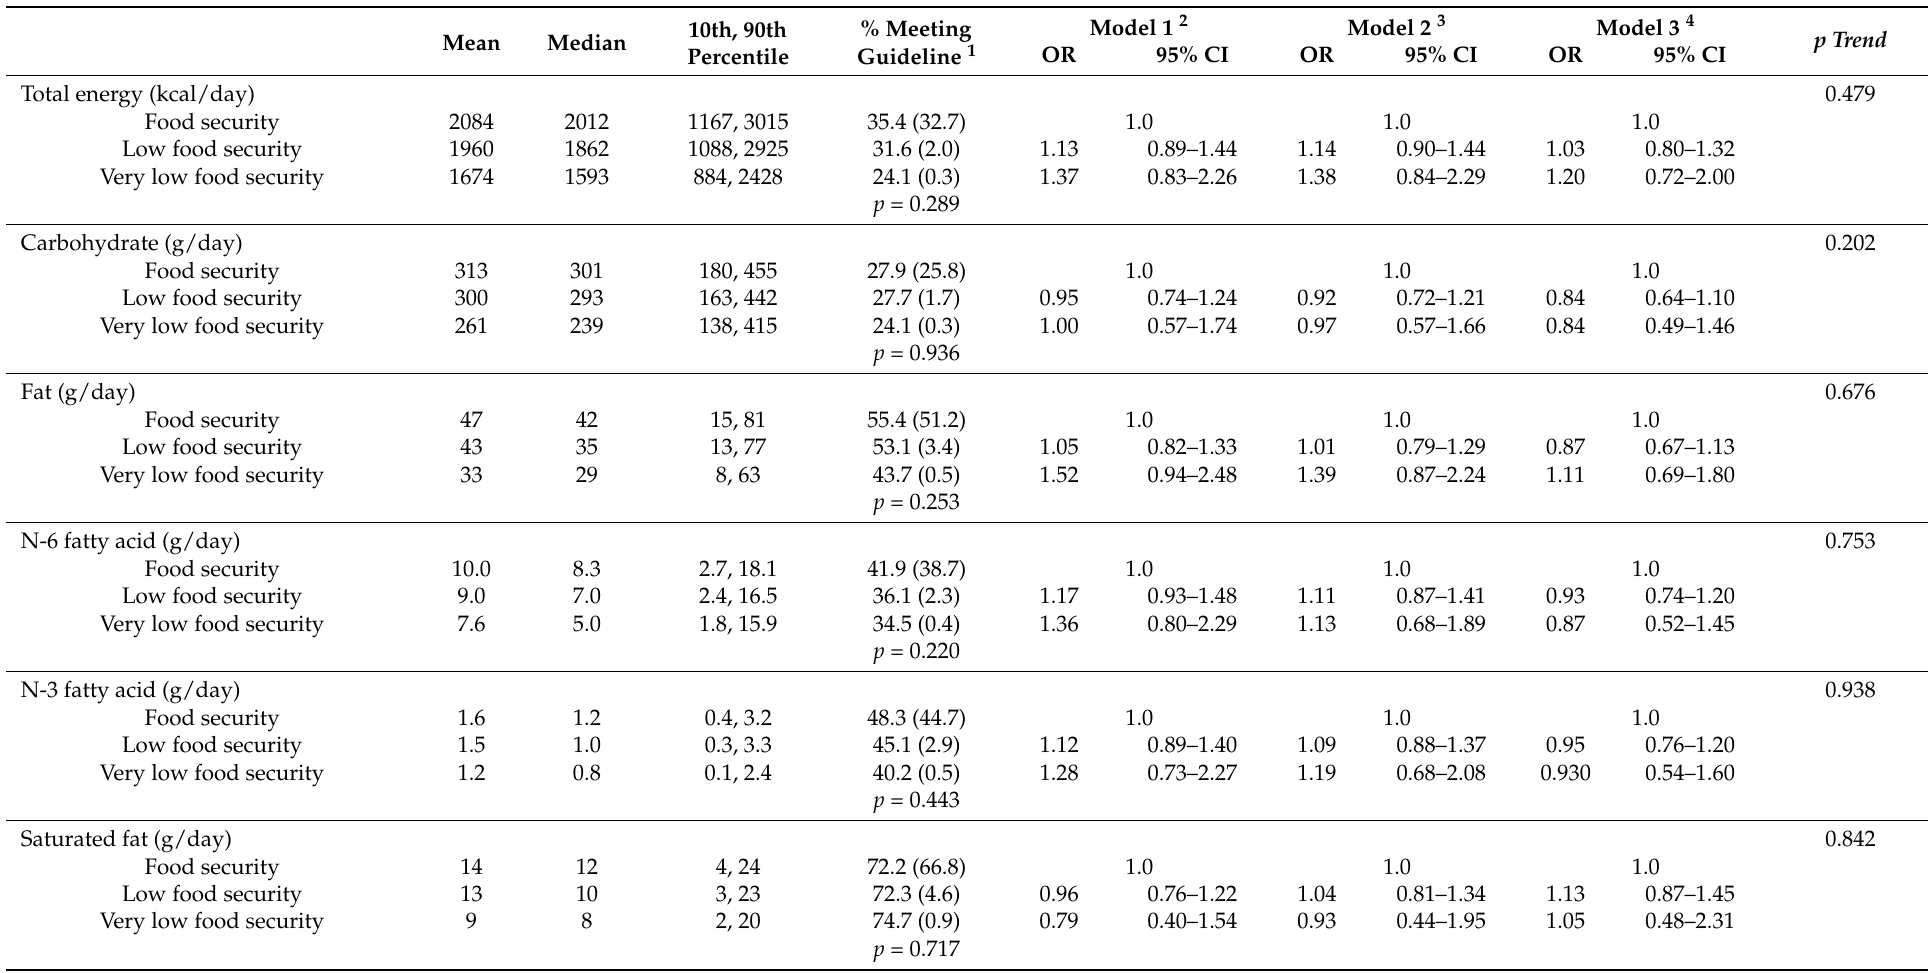
Table 2. Risk of nutritional inadequacy based on the KDRIs according to household food security